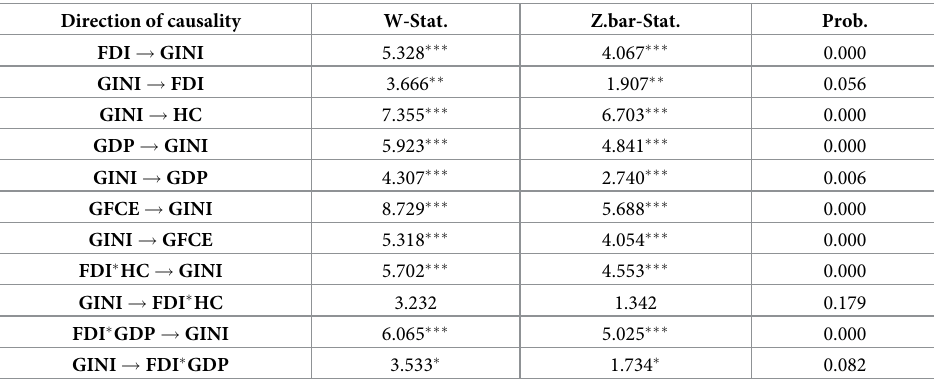
Note: ��� , �� , � represent 1%, 5%, 10% level of significance,